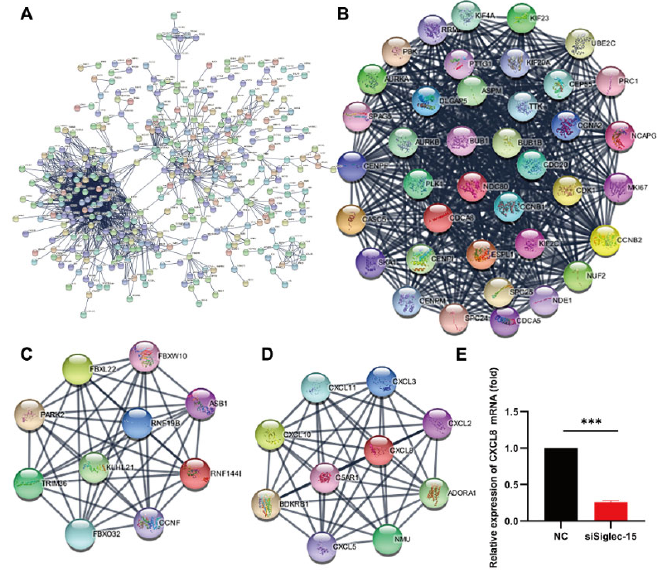
Figure 8. CXCL8 as a potential gene downstream of Siglec-15 in GCTB stromal cells. ( A ) The protein-protein interaction network by STRING. ( B – D ) There were 40 genes in module 1, 11 genes in module 2, and 11 genes in module 3 with the density of nodes. ( E ) CXCL8 was downregulated in Hs737. T cells with Siglec-15 knockdown by RT-PCR. *** p < 0.001.